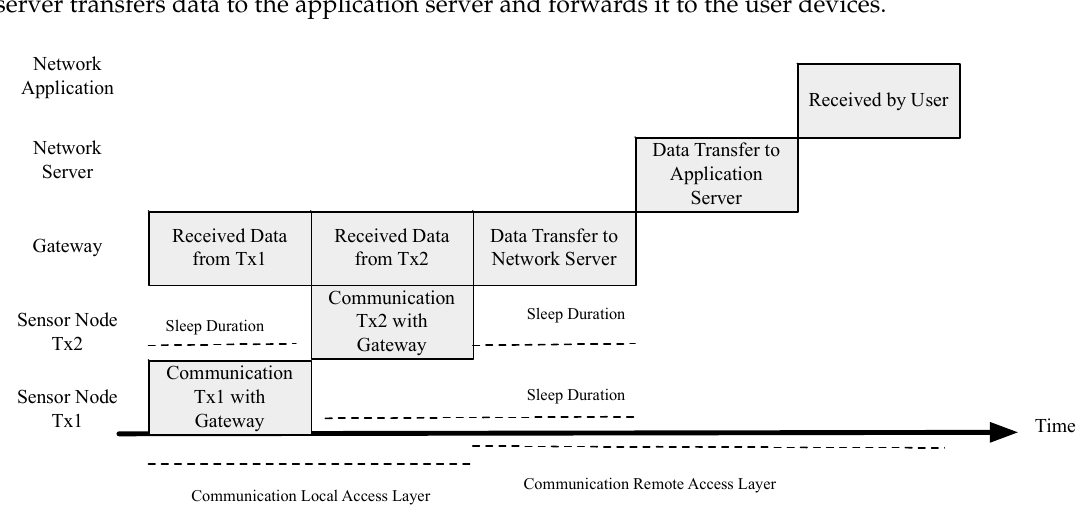
Figure 8. Time Sequences of Network Protocol.